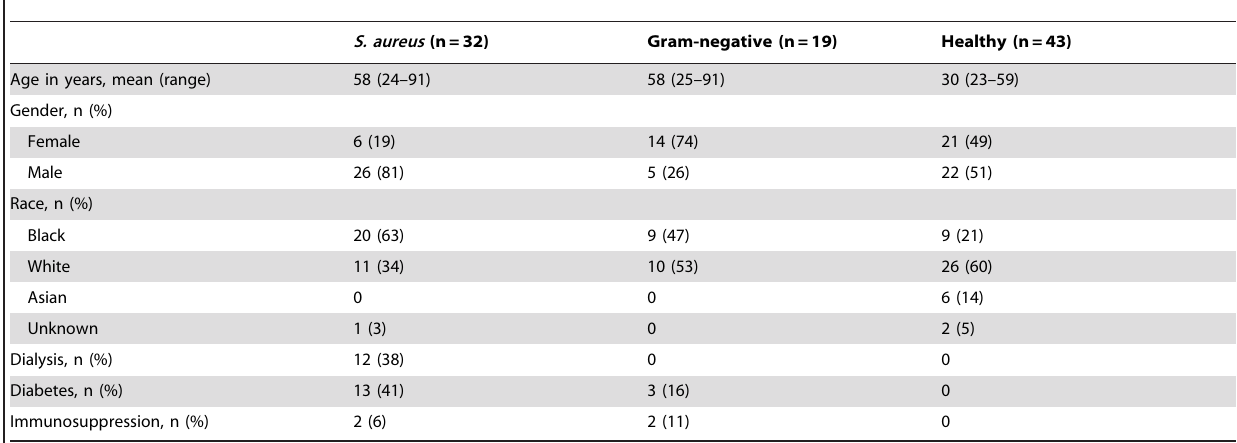
Table 2. Characteristics of human subjects used for S. aureus classifier derivation.